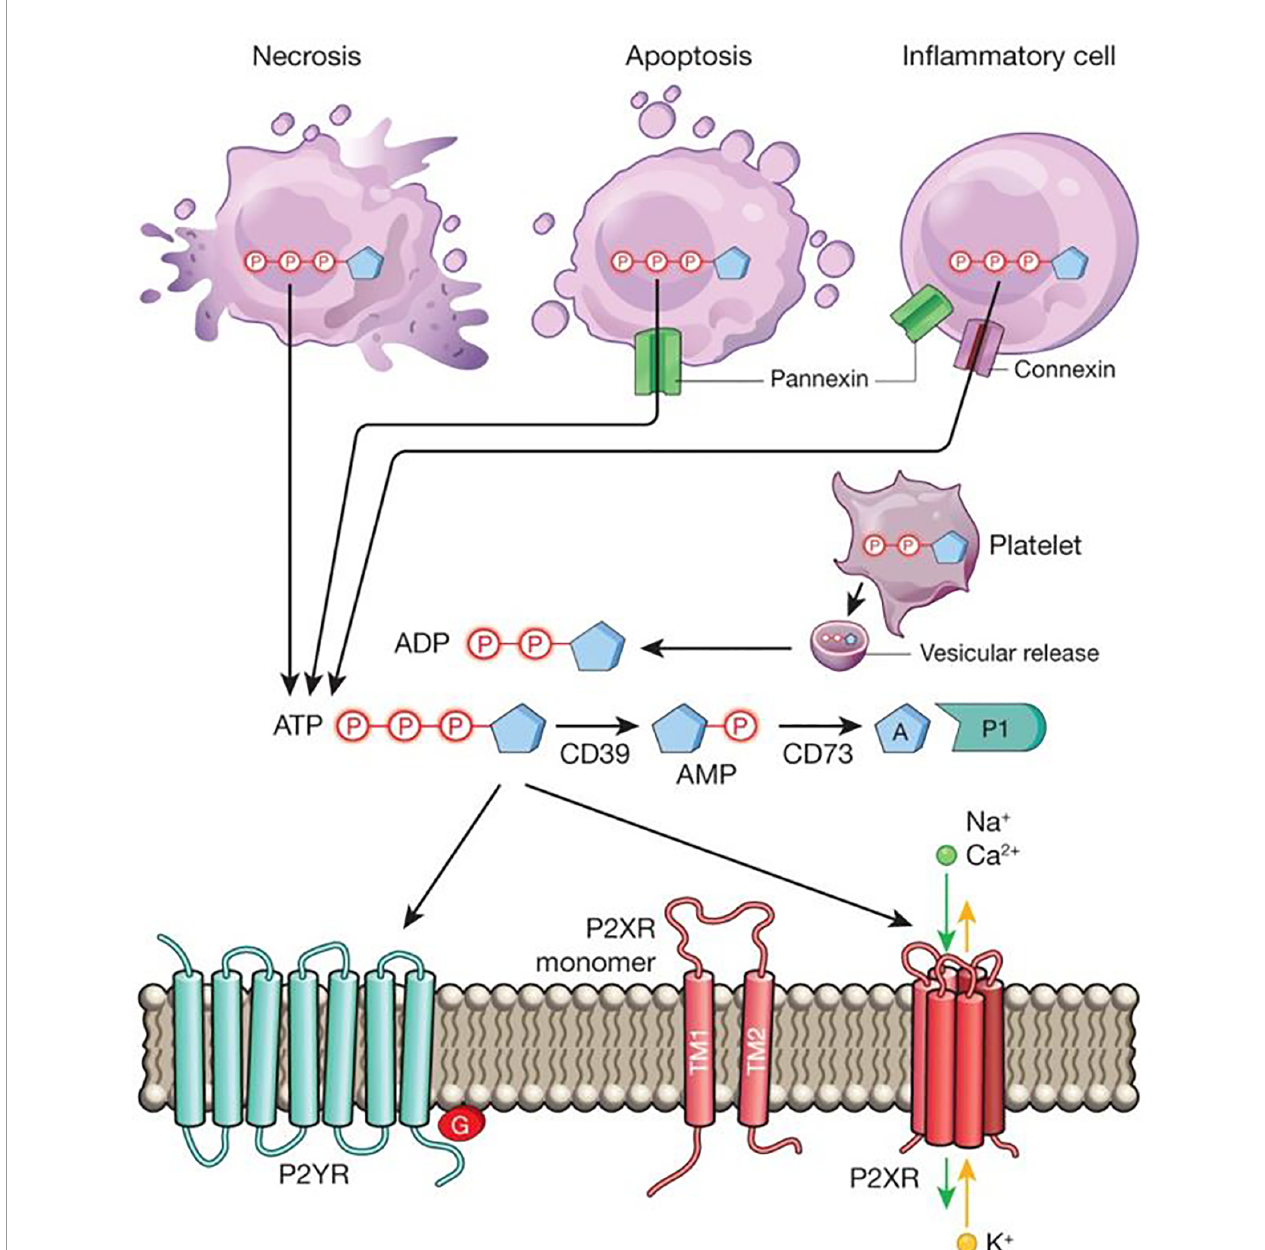
FIGURE 1 | Extracellular nucleotide release and signalling during in fl ammation. During in fl ammation, multiple cell types release nucleotides, for example ATP or ADP, from their intracellular compartments into the extracellular space. Nucleotides can be released during mechanical injury, necrosis, apoptosis or in fl ammatory cell activation. Several molecular pathways have been implicated in this process, such as vesicular ADP release from platelets, pannexin-mediated ATP release during apoptosis, and connexin- or pannexin-mediated ATP release from in fl ammatory cells, such as neutrophils. Extracellular nucleotides function as signalling molecules through the activation of purinergic P2 receptors. These receptors can be grouped into metabotropic P2Y receptors (P2YRs; GPCRs with seven transmembrane- spanning motifs) or ionotropic P2X receptors (P2XRs), which are nucleotide-gated ion channels. Each P2XR is formed by three subunits (P2XR monomers), each of which consists of two transmembrane regions, TM1 and TM2. Binding of three molecules of ATP to the assembled P2X channel causes opening of a central pore. These conformational changes allow for fl ux of ions such as sodium (Na+), calcium (Ca2+) and potassium (K+) across the membrane. ATP signalling is terminated by the enzymatic conversion of ATP to adenosine through the ectonucleoside triphosphate diphosphohydrolase CD39 (conversion of ATP/ADP to AMP) and the ecto- 5 ′ -nucleotidase CD73 (conversion of AMP to adenosine). Similar to ATP, adenosine (A) functions as an extracellular signalling molecule through the activation of purinergic P1 adenosine receptors. Material from: Idzko et al. (1). Reprinted with